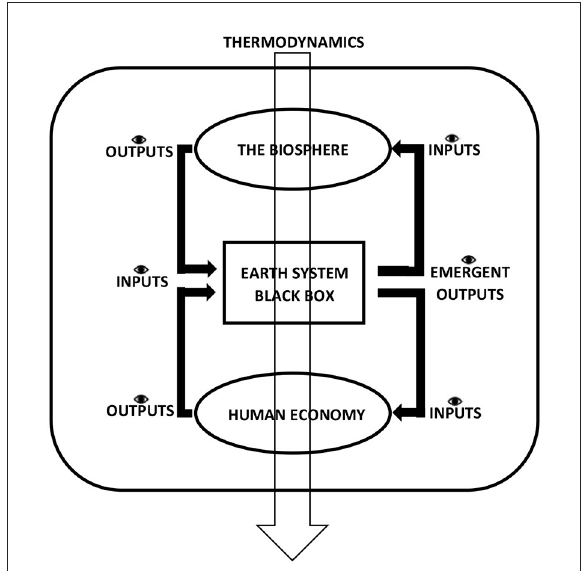
FIGURE1 Input, output and the black box of an emergent Earth system. The human economy and the Biosphere both provide input signals to the Earth system and then are recipients of output signals. In order to monitor the impacts of our activities we need to observe real-time feedback of all inputs and outputs through remote sensing and the internet of things (indicated by an eye symbol). Thermodynamics runs through all components as the framework in terms of direction and dynamics, leading to system adjustments in order to maintain maximum entropy production at the system level, with necessary changes at the component